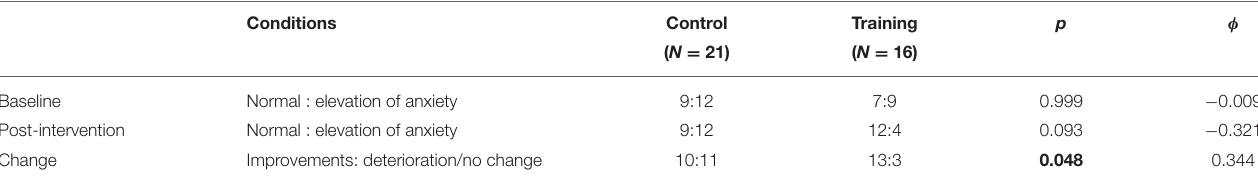
TABLE 4 | Fisher’s exact tests for the PAS-TC.